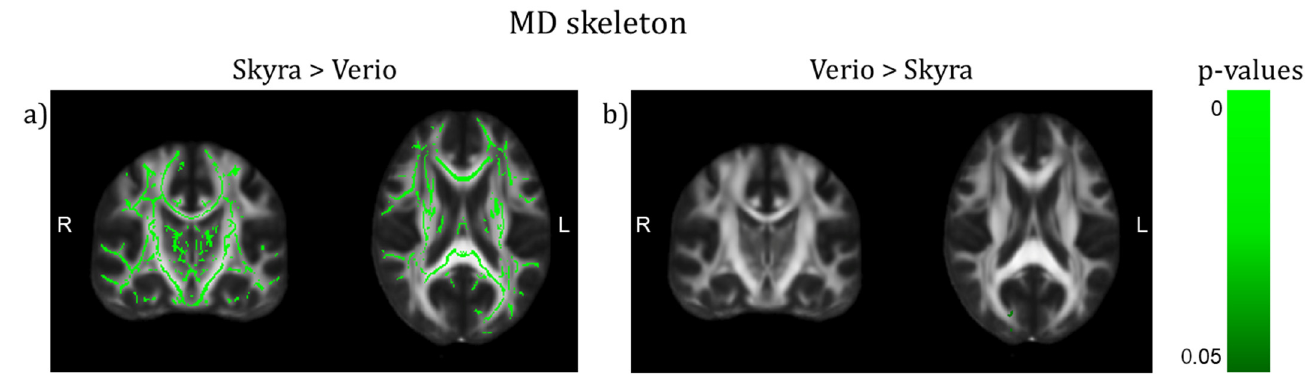
Figure 4. TBSS on the MD skeleton of scanner differences (CMRR sequence) after preprocessing with denoising (TFCE corrected, highlighted tracts: p < 0.05, (y,z) = ( − 18,19)). ( a ) The whole brain WM skeleton (except for a small part in the right occipital lobe) shows higher values in Skyra than in Verio. ( b ) Only a small white matter region in the right occipital lobe shows higher values in Verio than in Skyra.